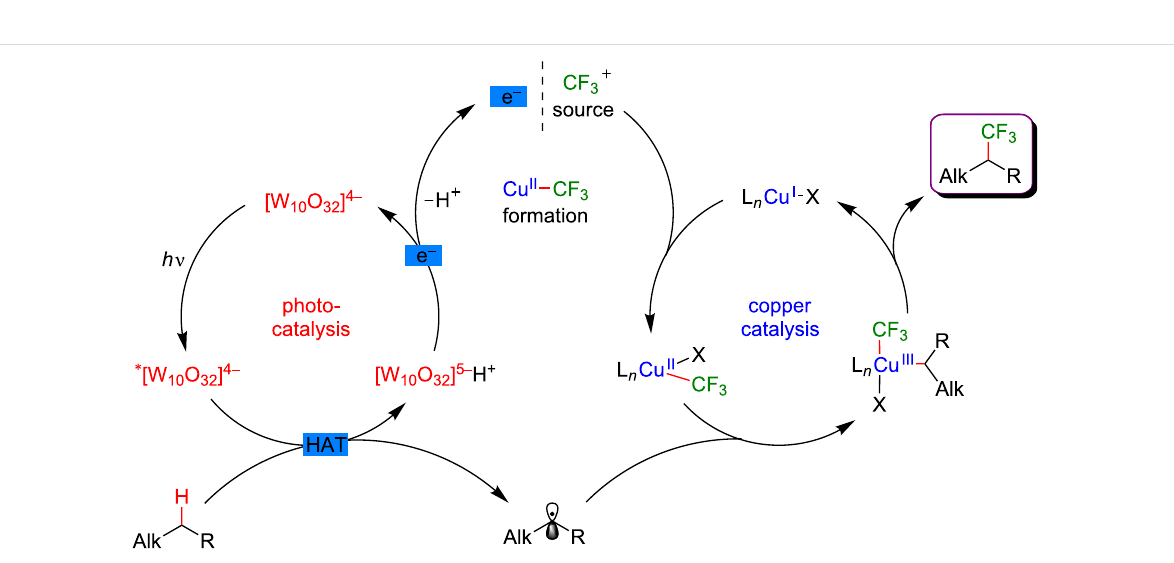
Figure 80: Proposed mechanism for the C–H trifluoromethylation of strong aliphatic